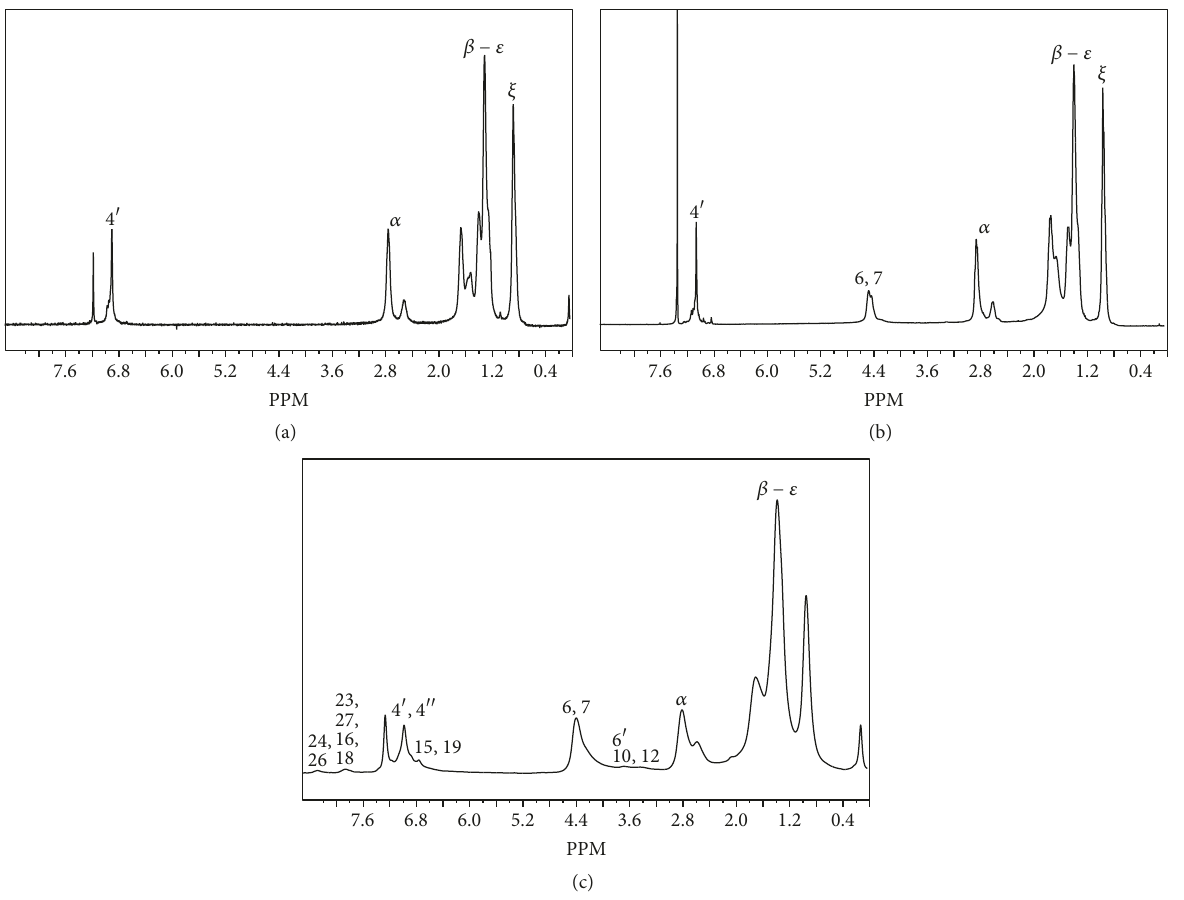
Figure 2: 1 H NMR spectra of (a) poly(3-HT)-2, (b) poly(3-HT- co -EDOT), and (c) poly(3-HT- co -EDOT- co -TDR1) [19] in CDCl 3 .